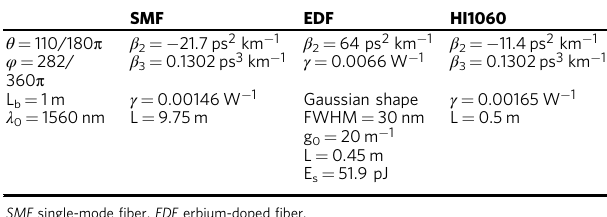
Table 1 The parameters used in the numerical simulation of the spectral beating